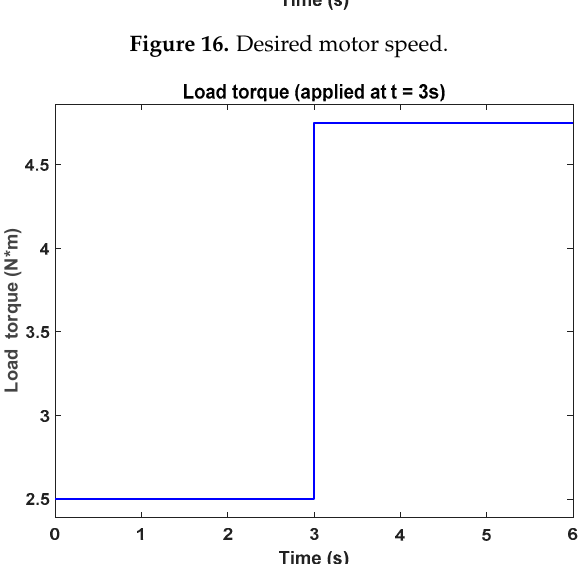
Figure 17. Load torque as disturbance.